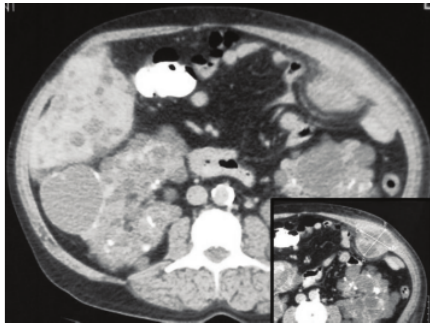
Figure 1: Abdominal Computed Tomography: abscess of the left anterior abdominal